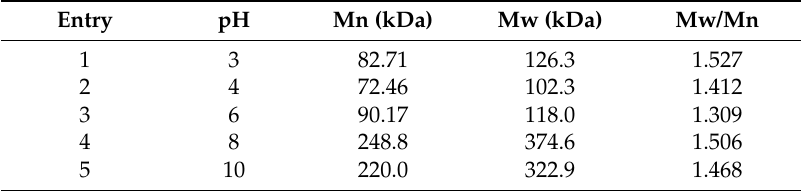
Table 3. Average molecular weights and dispersity indices of LMW-HA under different pH. Entry